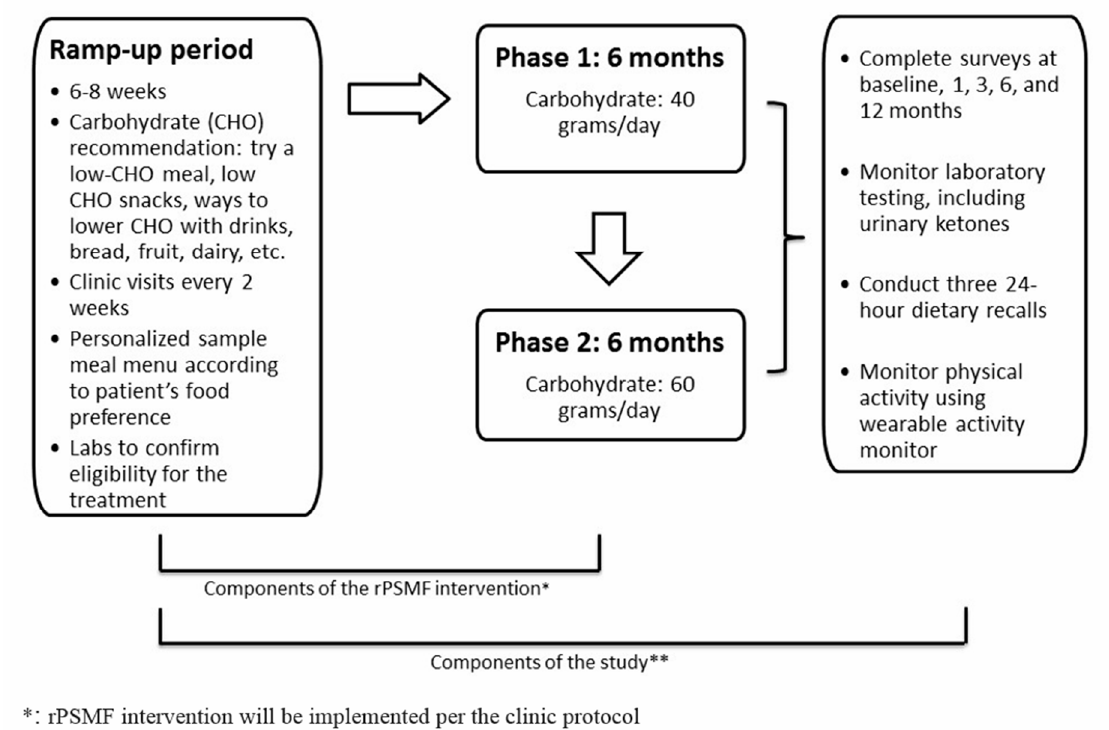
Figure 1. Schematic representation of the rPSMF intervention and study protocol .